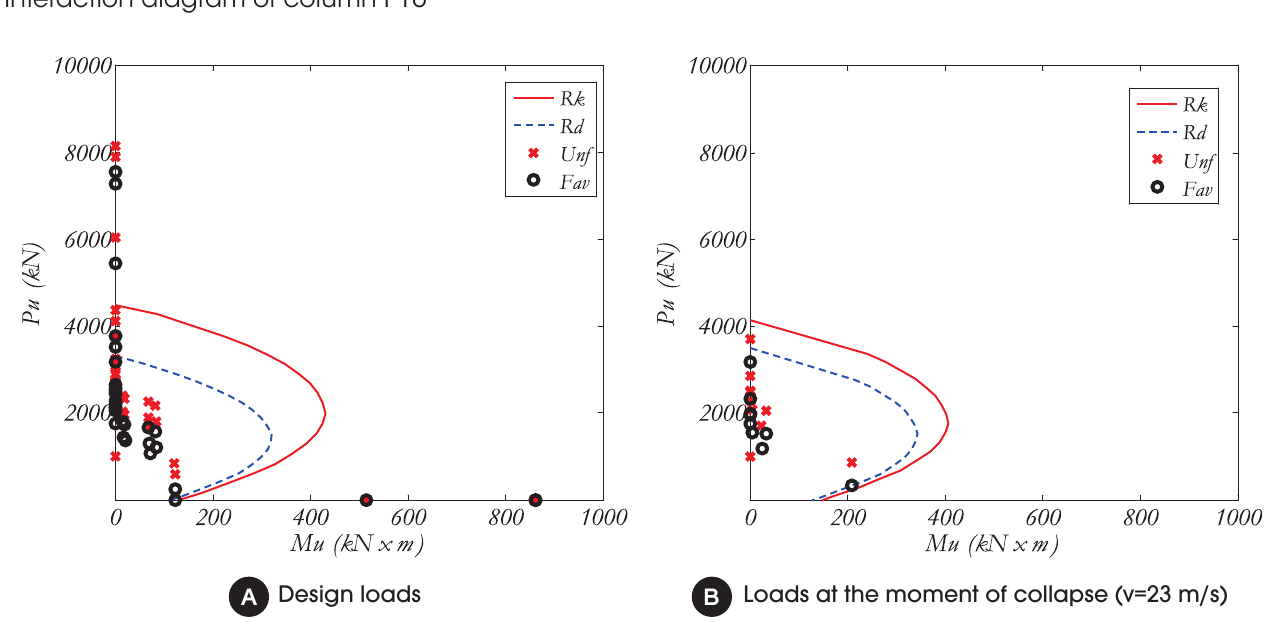
A Design loads B Projection of loads at the moment of collapse Figure 19 Interaction diagram of column P16